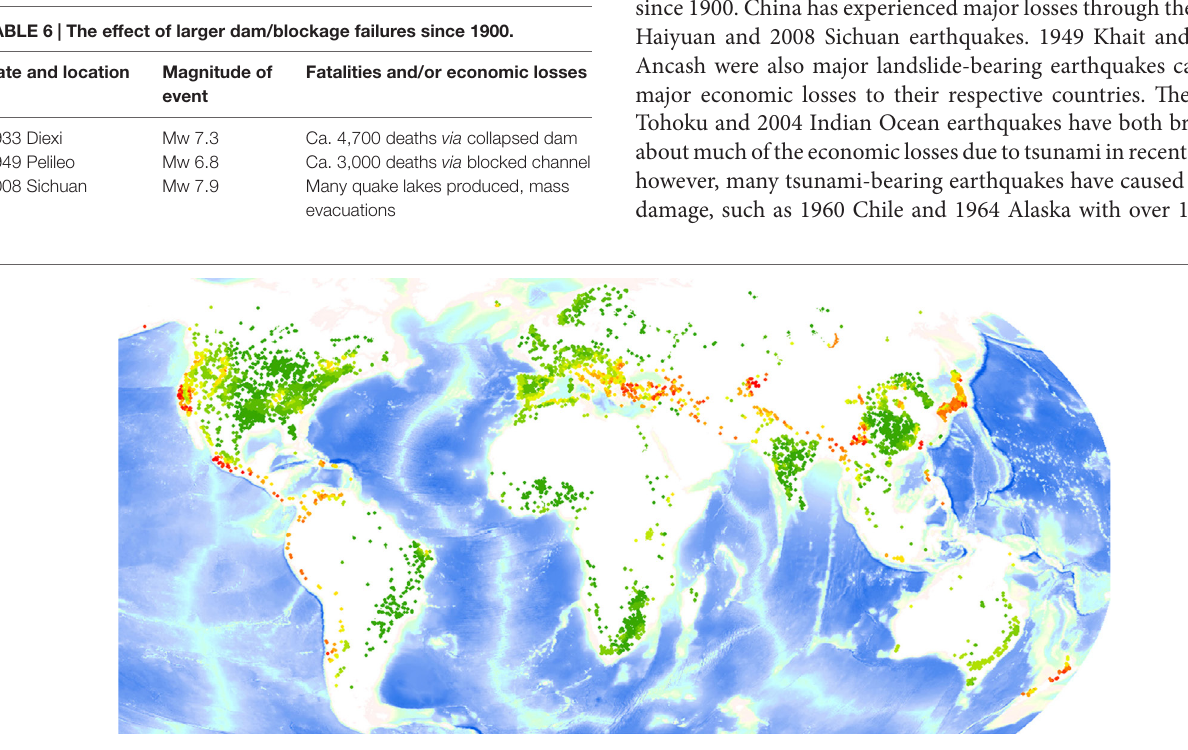
FigUre 4 | The earthquake hazard of the 6,800 + dams and reservoirs worldwide from the granD database [in comparison to the gshaP (10% exceedance in 50 years)] .